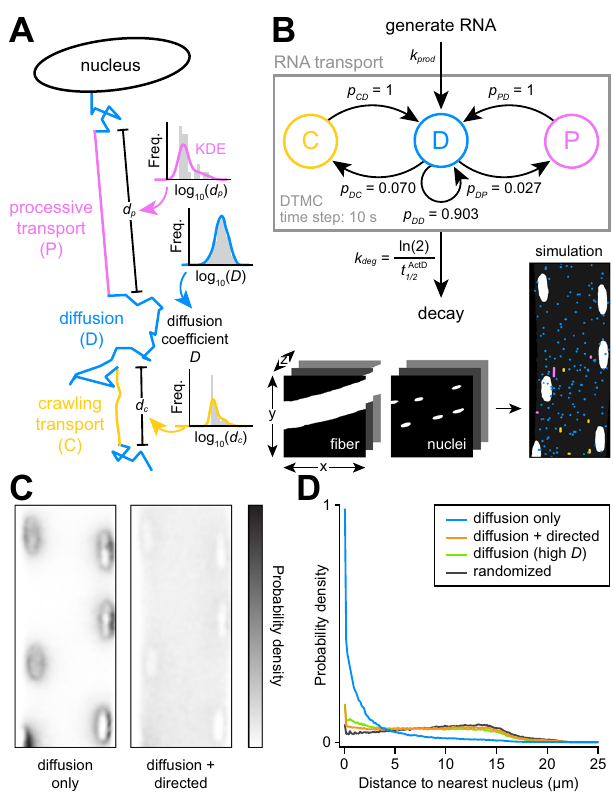
Fig. 9 Computational simulation con fi rms that directed transport is required to disperse mRNA in myo fi bers. A Diagram of RNA mobility states modeled in the simulation of RNA motion in myo fi bers. B Network diagram of the discrete-time Markov chain (DTMC) model developed to simulate RNA generation, motion, and decay. C Comparison of RNA localization patterns observed in 1000 h simulations of Polr2a RNA either with or without directed transport states. D Distance to nucleus measured for simulated Polr2a RNAs with (orange) or without (blue) directed transport states. Shown for comparison is the distribution from a simulation of Polr2a mRNAs in the high-mobility diffusion state (green) and a null distribution generated from randomly selected cytoplasmic coordinates